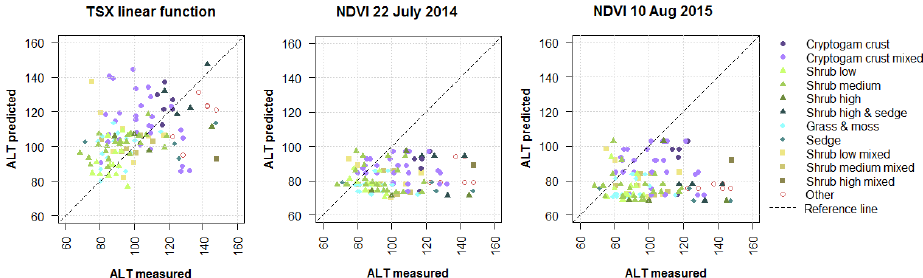
Figure 6. Comparison between predicted and measured ALT values at the CALM grid with differentiation between vegetation types for TerraSAR-X and NDVI approaches.